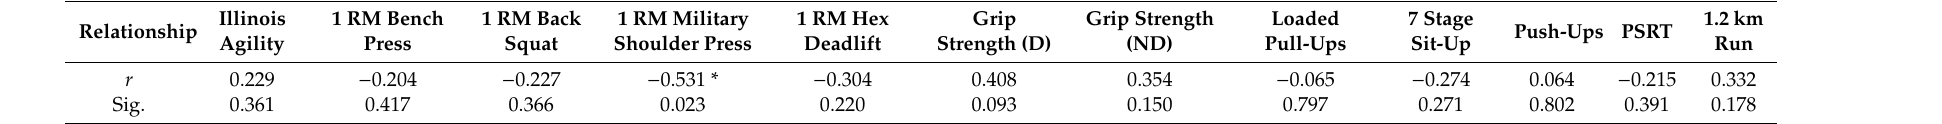
Table 3. Pearson’s correlations between fitness measures and the OSPA.